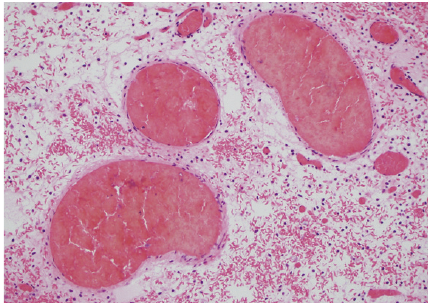
Figure 1: Medium power view showing edema with rim of ovarian stroma with stromal luteinization.